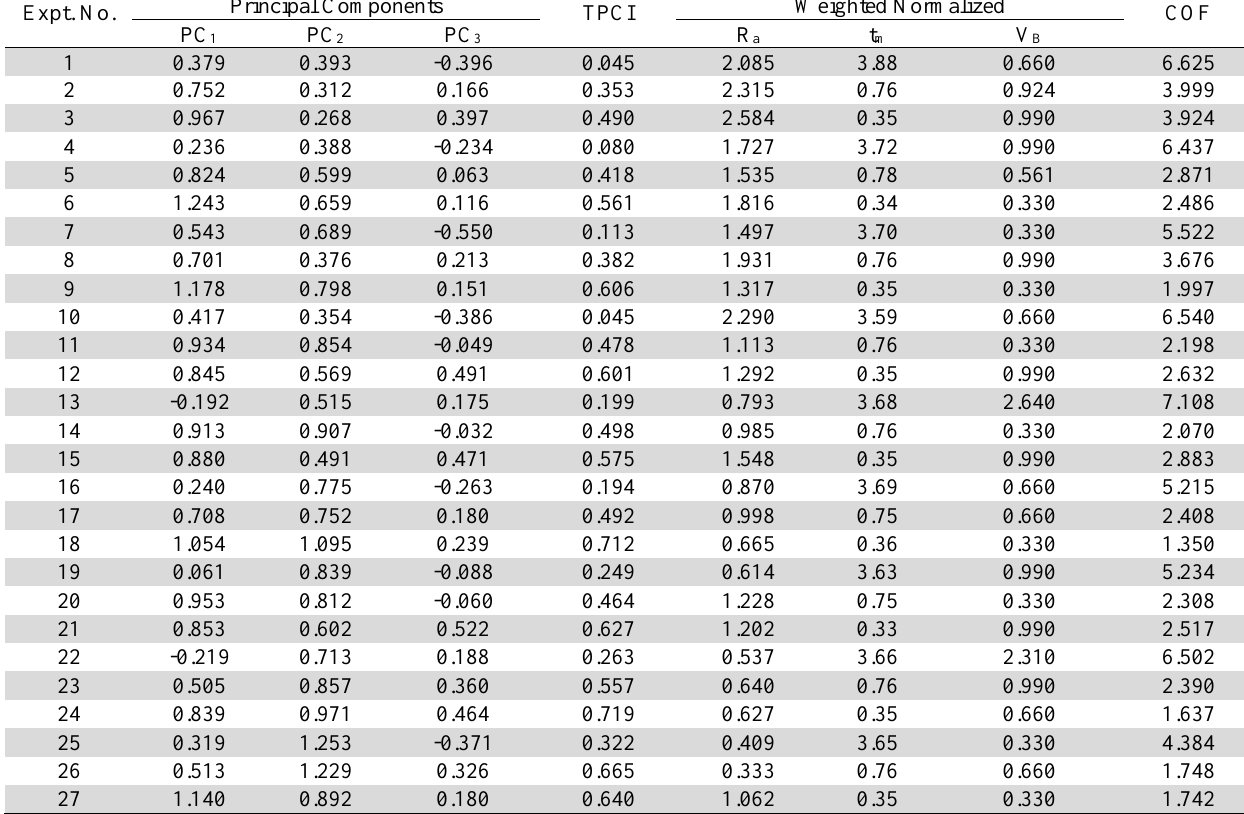
Principal components and COF for the experimental runs Expt.